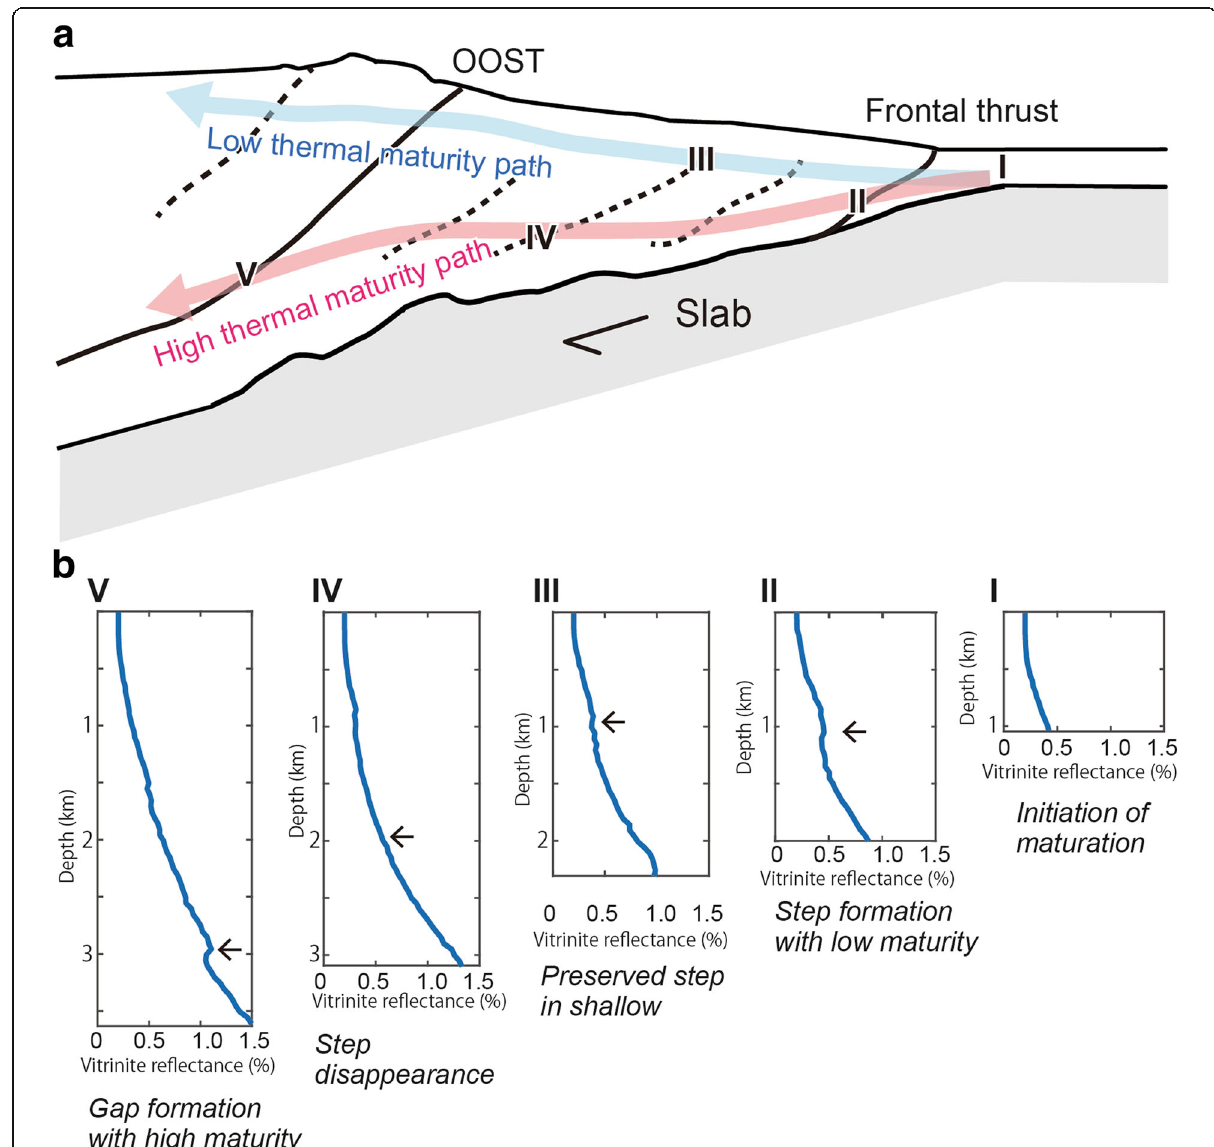
Fig. 8 Schematic of an accretionary wedge with two main sediment flow pathways: a a shallow and low thermal maturity pathway and a deep high thermal maturity path and b vertical profiles of vitrinite reflectance in an accretionary wedge. The steps in vitrinite reflectance across the fault are associated with fault formation and reactivation, as depicted with arrows in II and V. The step in vitrinite reflectance across the fault is preserved in the shallow part of the wedge, as depicted by an arrow in III. The disappearance of the step with high temperatures and the overprint that depicts higher vitrinite maturity than that obtained in previous stages are illustrated using an arrow in